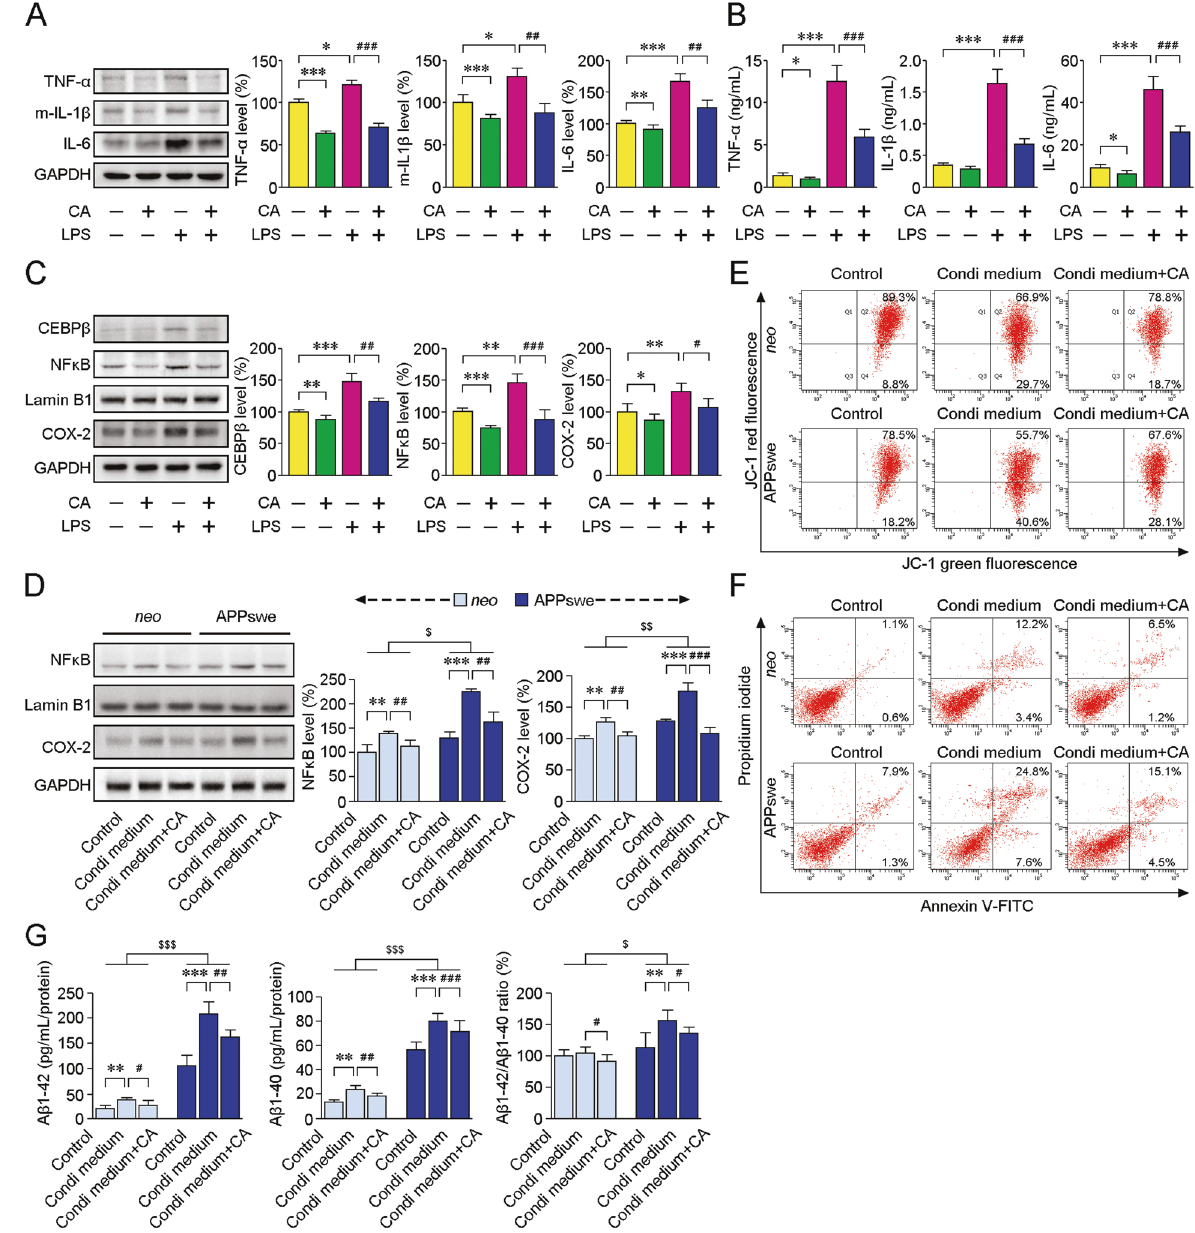
Fig. 7 CA treatment abolishes the effects of glia-secreted proin fl ammatory cytokines on neuronal damage and A β secretion. A172 human glioblastoma cells were incubated with 1 µg/mL LPS for 24 h to trigger proin fl ammatory responses and then treated with CA at a fi nal concentration of 1 µM for 12 h. A Western blot analysis was performed to evaluate the protein expression of IL-1 β , IL-6 and TNF α . B The secretion of IL-1 β , IL-6 and TNF α was measured by ELISA. C Representative blots showing the protein levels of COX-2, nuclear CEBP β and NF κ B in A172 cells. D SH-SY5Y cells overexpressing human APPswe or empty vector ( neo ) were cultured in LPS-primed cell-conditioned medium and treated with or without CA. The protein levels of nuclear NF κ B and COX-2 were measured. E The mitochondrial transmembrane potential of APPswe and neo cells was determined by FCM. The percent of red and green fl uorescence signal of JC-1 was measured to assess the degree of mitochondrial depolarisation. F Apoptosis of APPswe and neo cells were labelled by Annexin V-FITC/PI staining and analysed by FCM. G The secretion of A β 40 and A β 42 by APPswe and neo cells was measured by ELISA. The ratio of A β 42 to A β 40 was quanti fi ed. The data were representative of at least three independent experiments. * p < 0.05, ** p < 0.01 and *** p < 0.001 vs untreated cells; # p < 0.05, ## p < 0.01 and ### p < 0.001 vs the LPS-stimulated group ( A – C ). ** p < 0.01 and *** p < 0.001 vs the group treated with the medium of A172 cells not incubated with LPS (Control); # p < 0.05, ## p < 0.01 and ### p < 0.001 vs the group incubated with the medium of LPS-primed A172 cells without CA treatment; $ p < 0.05, $$ p < 0.01 and $$$ p < 0.001 vs neo cells ( D , G ). Data were submitted to two-way ANOVA with Fisher LSD post hoc tests. Values represent the mean ± SD. All experiments were repeated at least three times.